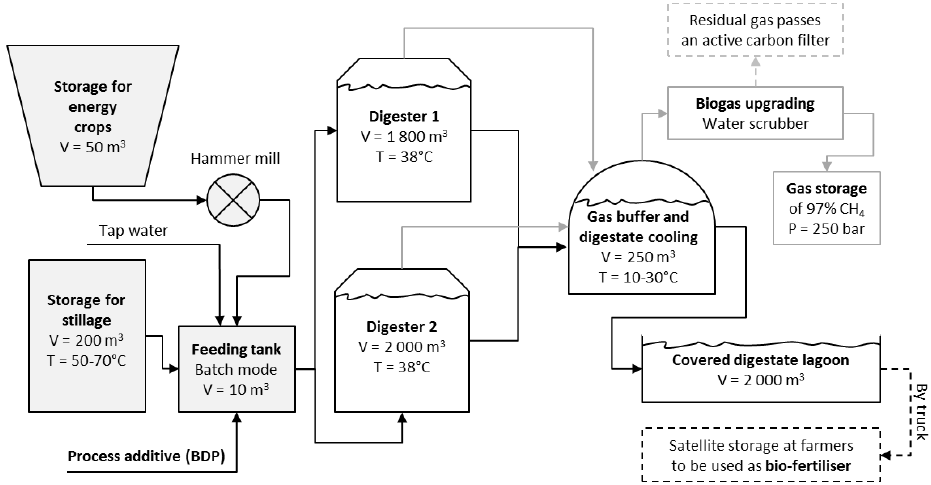
Figure 5. Schematic diagram of process flow at the Norrköping biogas plant. Black arrows represent organic material flows, while grey arrows represent gas flows. Grey boxes represent upflow processes, white boxes represent main production process and boxes with crosshatched lines represent downflow